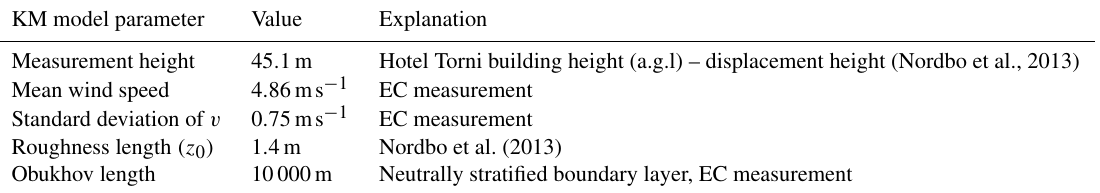
Table 3. Parameters used in the Korman and Meixner footprint